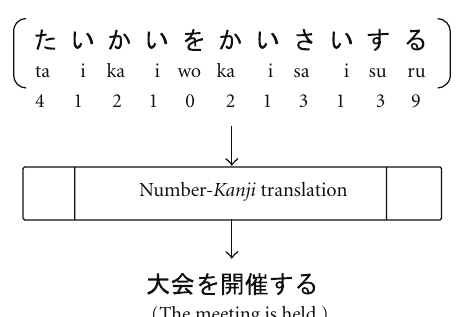
Figure 3: Example of